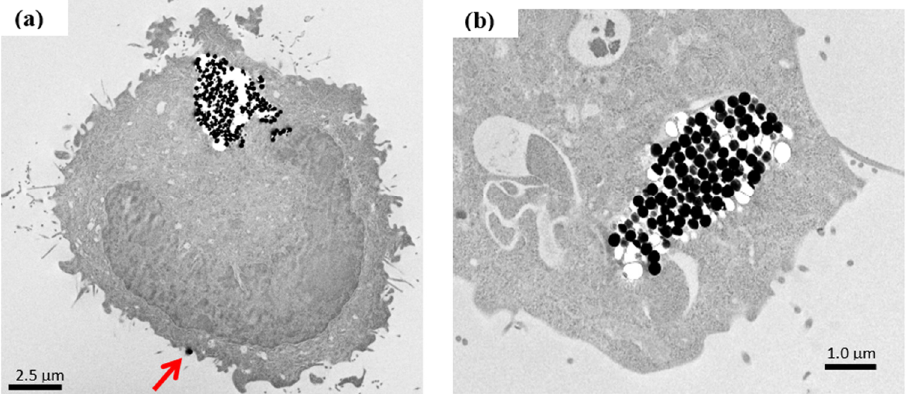
Figure 7. TEM micrograph of SiO 2 @Fe/SiO 2 spheres’ uptake by L929 cells. Internalization by endocytosis ( a ) and distribution in cytoplasm ( b ) were observed.